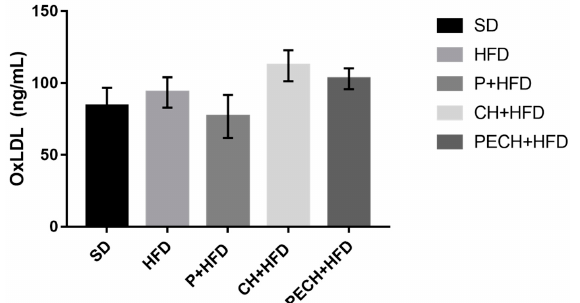
Figure 7. Effect of different diets on oxidized LDL (OxLDL) levels. The different diets compared were standard diet, (SD, n = 4), high-fat diet (HFD, n = 8), phenolic-enriched high-fat diet (P + HFD, n = 8), lyophilized cooked ham enriched high-fat diet (CH + HFD, n = 8) and lyophilized phenolic enriched cooked ham enriched high-fat diet (PECH + HFD, n = 8). As expected, after the target screening strategy and the information provided by MS and MS/MS modes, six phenolic-derived metabolites were identified in urine samples from the P + HFD and PECH + HFD groups confirming the bioavailability of these phenolics (Table 2). The metabolites were detected after UPLC-QTOF analysis, although they were not quantified due to the low concentrations of the polyphenol metabolites in urine that were below their LOQ (15 nM for hydroxytyrosol glcuronide; 150 nM for 5-(3 ′ .4 ′ -dihydroxyphenyl- γ -valerolactone, and 4 nM for 5-(3 ′ ,4 ′ - Dihydroxyphenyl- γ -valerolactone 3 ′ -sulphate). No phenolic-derived metabolites were found in the rest of the groups. No phenolic-derived metabolites were detected in the remaining groups. It should be taken into account that epicatechin sulphate, 5-(3 ′ ,4 ′ -Dihydroxyphenyl- γ -valerolactone, 5-(3 ′ ,4 ′ - Dihydroxyphenyl)- γ -valerolactone 3 ′ -sulphate and HXT glucuronide were detected in all urine samples from the two groups fed with the phenolic blend. However, ferulic acid 4-sulphate and feruloylquinic acid glucuronide were only identified in the group fed with the enriched phenolic compounds diet alone (P + HFD). Table 2. Phenolic derived metabolites identified in urine.